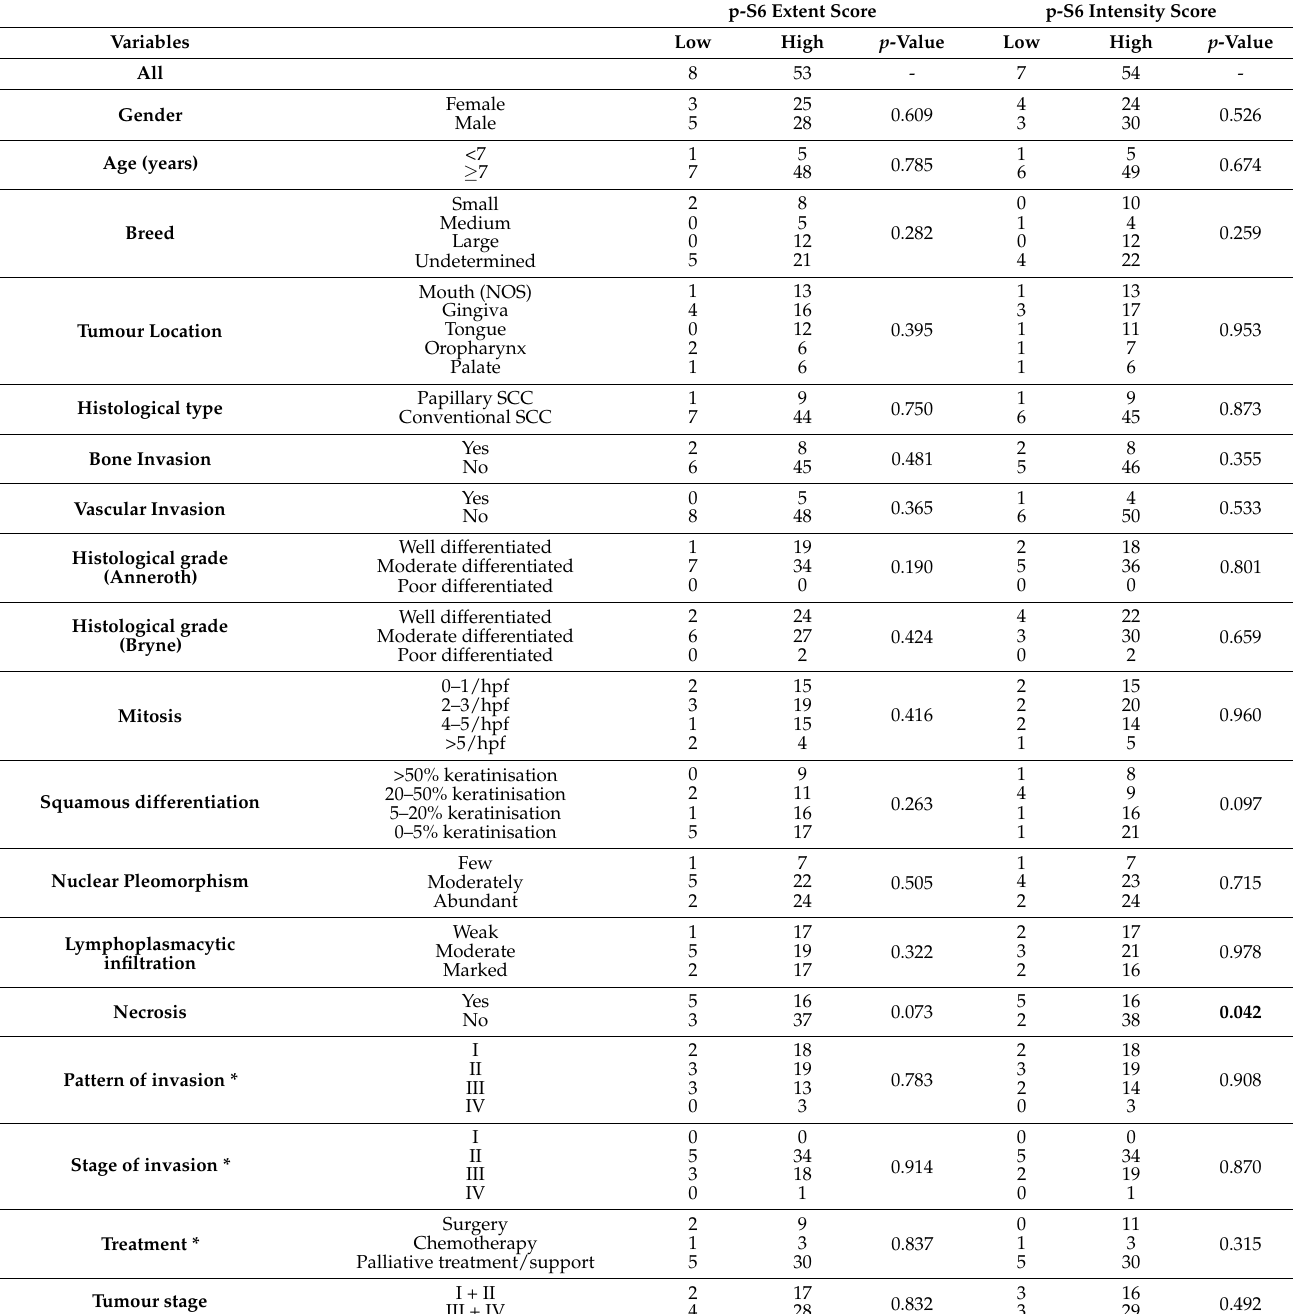
Table 3. Clinicopathological characteristics of the OSCC patients and its association with p-S6